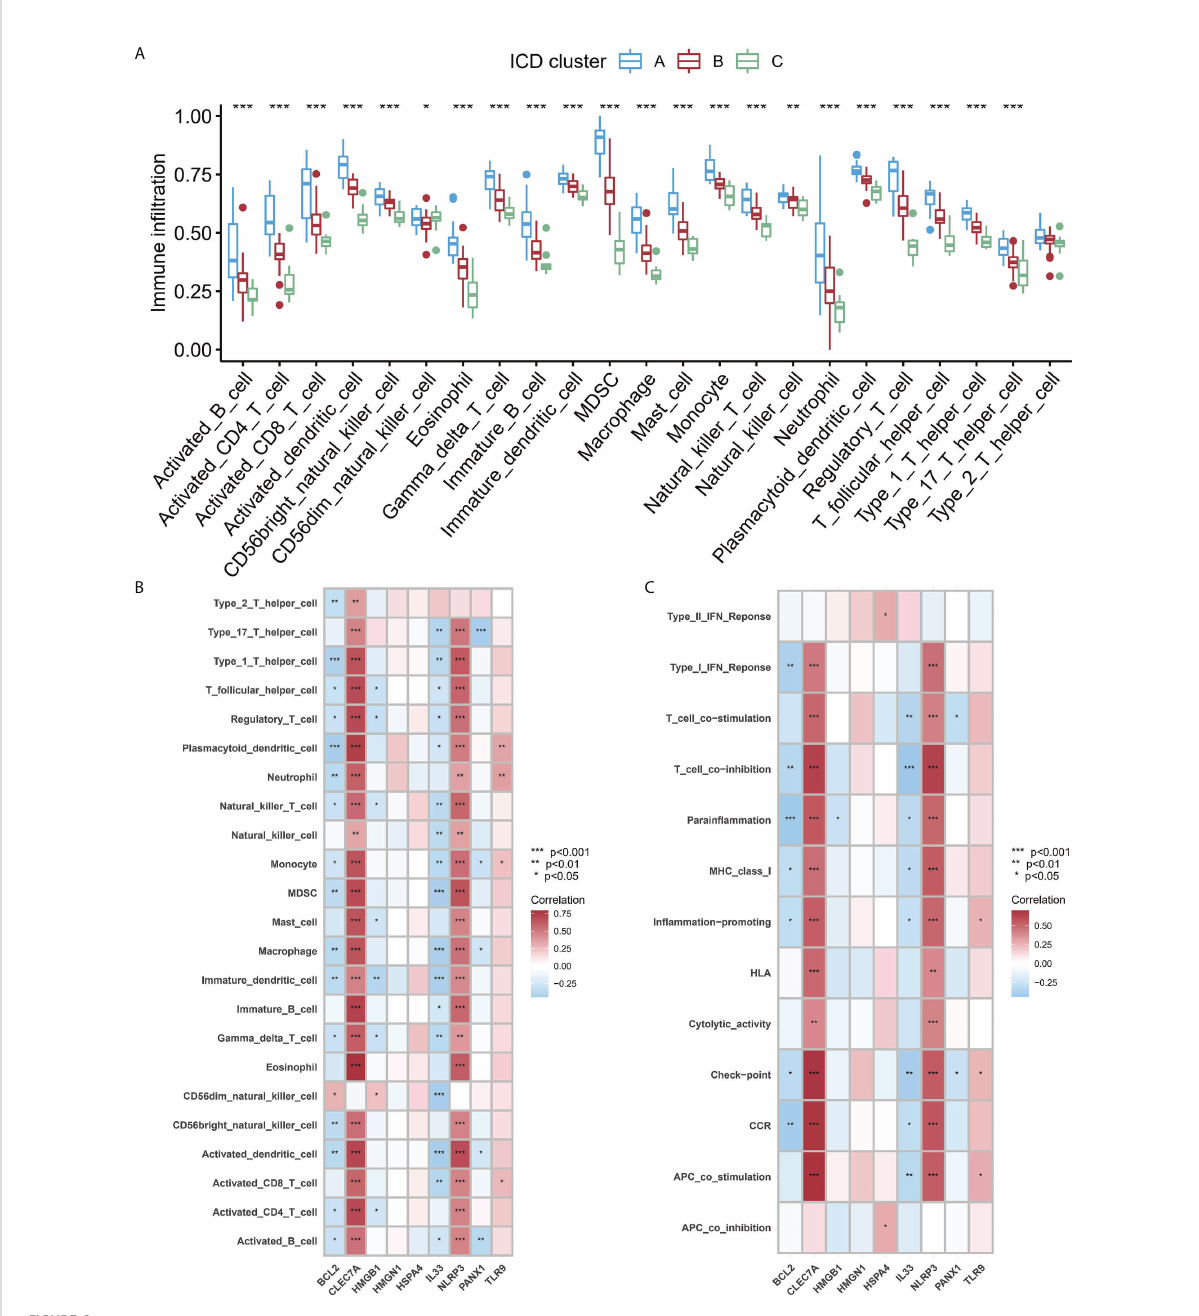
FIGURE 6 (A) Signi fi cant differences were noted in each type of immune microenvironment -in fi ltrating immune cells in the three ICD patterns. (B, C) . Correlation between the immune reaction gene-sets, in fi ltrating immunocytes, and ICD-regulators. (B) The square plot highlighted the relationship between every dysregulated immune microenvironment in fi ltration cell type and each dysregulated ICD-regulators (C) Square plot highlighting the relationship between every dysregulated immune response gene set and every dysregulated ICD-regulators. *P < 0.05, **P < 0.01, ***P <